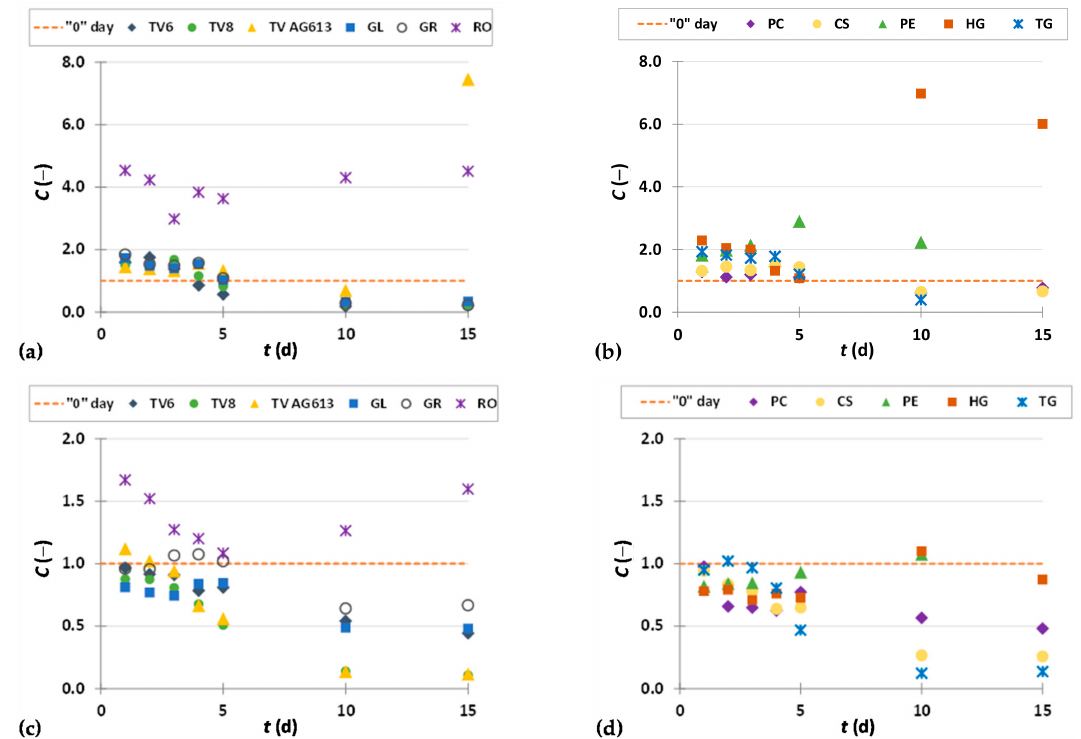
Figure 5. Dimensionless content ( C = C i /C o ) of o -coumaric acid ( a , b ) and p -coumaric acid ( c , d ) in GP extracts before biological treatment (‘0’ day) and after 1–15 days of biological treatment with TV6, TV8, TV AG613, GL, GR, RO ( a , c ), and PC, CS, PE, HG, TG ( b , d